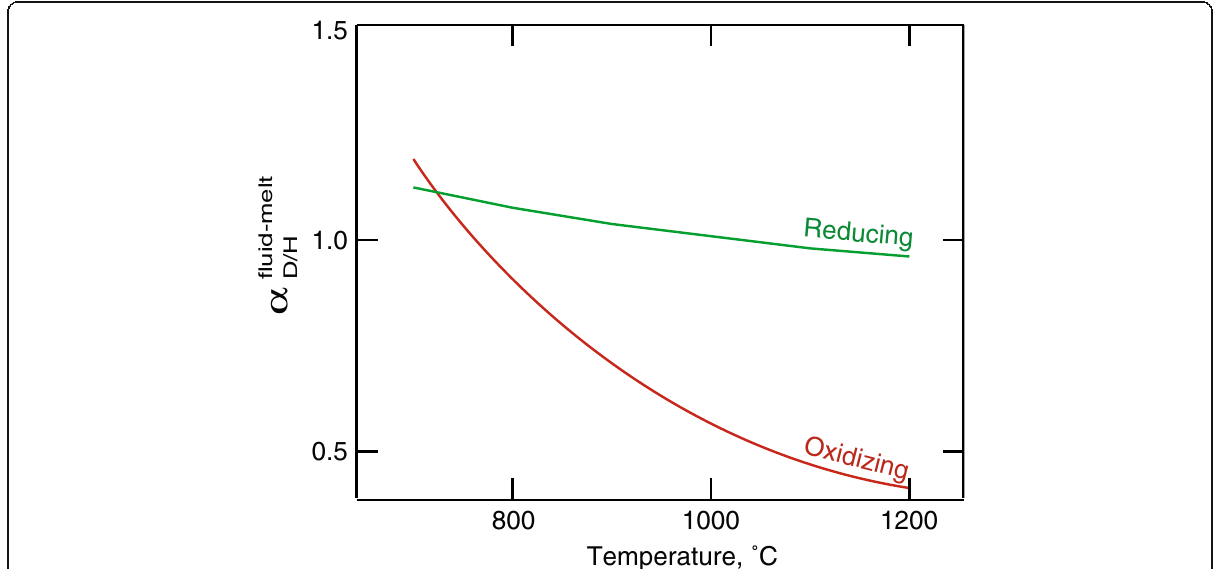
Fig. 7 D/H fractionation factor between fluid and melt as a function of temperature and silicate – COH systems under reducing and oxidizing conditions (data from Mysen 2015a)